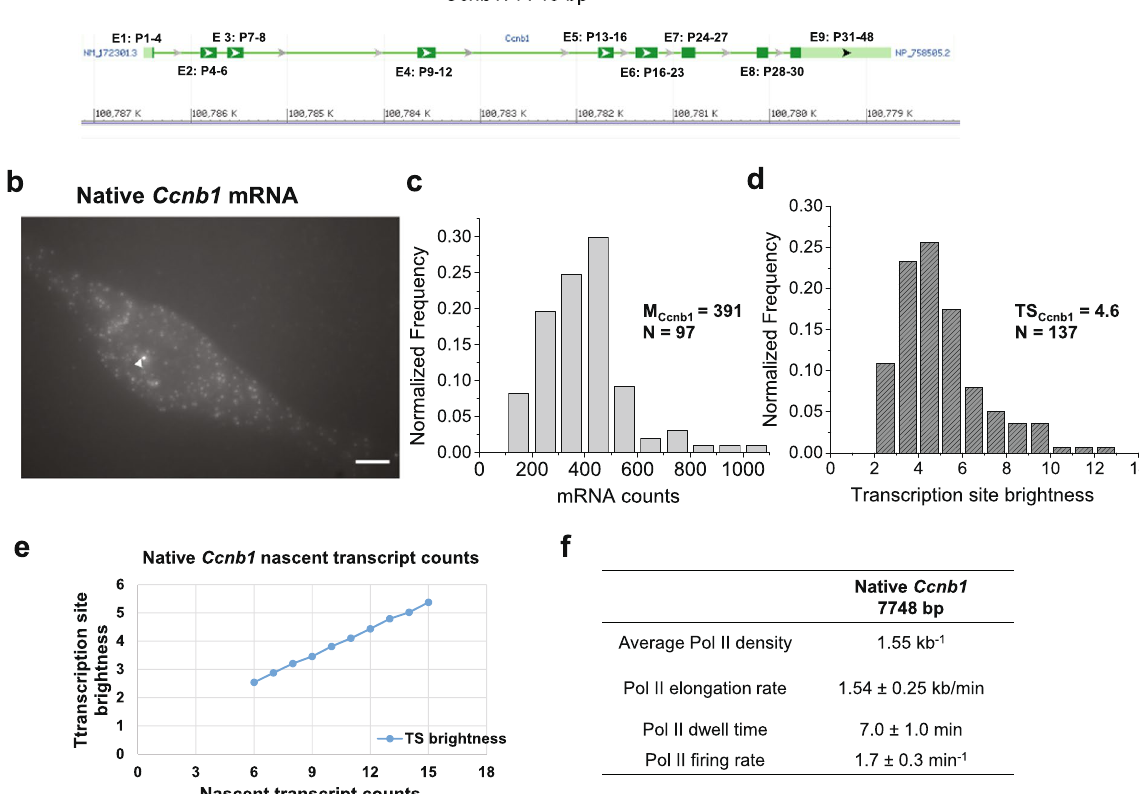
Figure 3. Quantifying mRNA counts and nascent transcript counts of the native Ccnb1 gene . ( a ) An NCBI genome browser view showing exons (green) and introns of the mouse Ccnb1 gene (7,748 bp). Positions of forty-eight 20-mer RNA FISH probes (P1 to P48) that target Ccnb1 exons (2,316 bp) are indicated. ( b ) A representative single molecule RNA FISH image of the native Ccnb1 gene in Ccnb1 :: Luc - MS2 (clone 96) cells. Scale bar: 5 µ m. White arrowhead indicates the TS. ( c , d ) Histograms of measured mRNA counts and TS brightness of the native Ccnb1 gene. M Ccnb1 and TS Ccnb1 indicate the median mRNA count and the median TS brightness of the native Ccnb1 gene measured by FISH analysis using Ccnb1 exon probes, respectively. N indicates the measured cell number and TS number, respectively. FISH images from one experiment were analysed. ( e ) Plot of calculated TS brightness versus nascent transcript counts according to RNA FISH probe locations along the native Ccnb1 gene. ( f ) Table summarizing estimated RNA Pol II density, Pol II elongation rate, dwell time and firing rate at the native Ccnb1